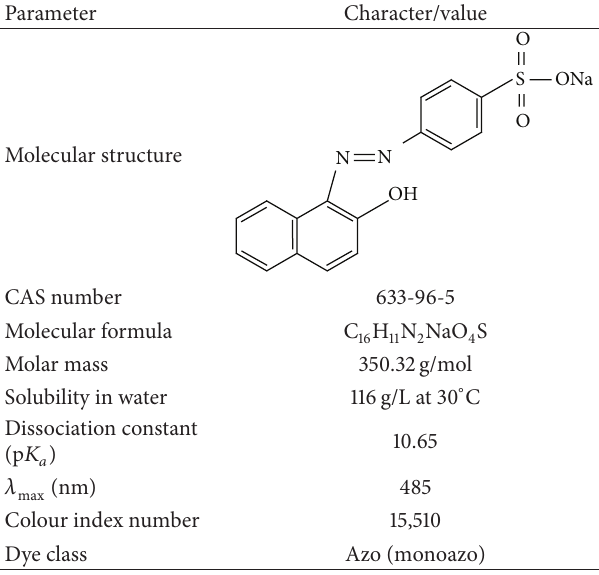
Table 1: Main properties of OII used in this